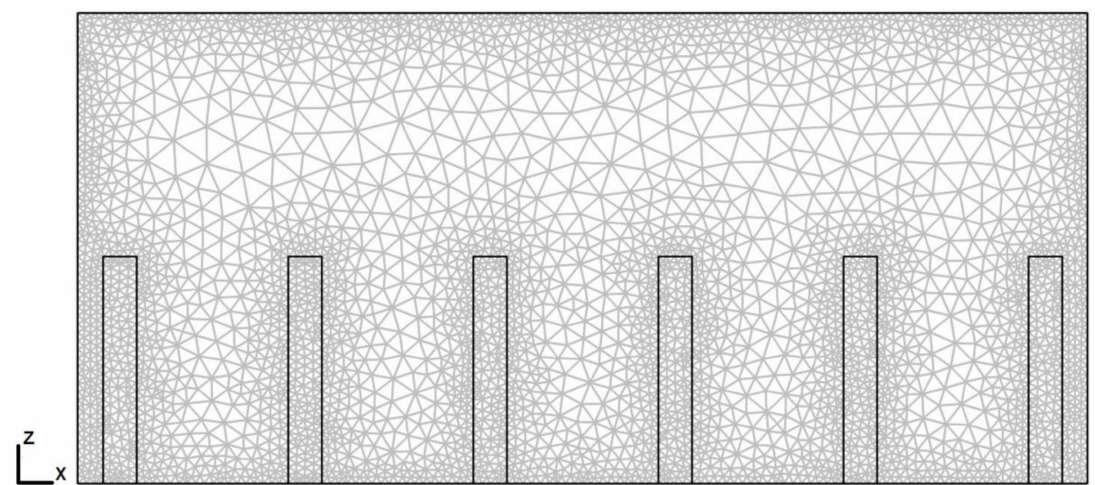
Figure 3. Cross-section of the computational mesh used in the